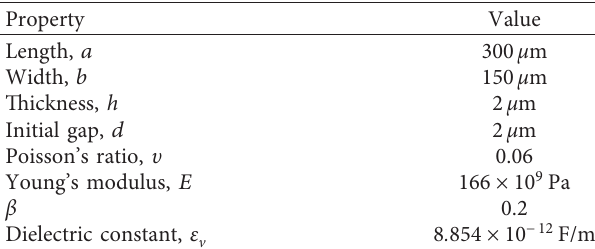
Table 1: Geometric and material properties of the microplate.